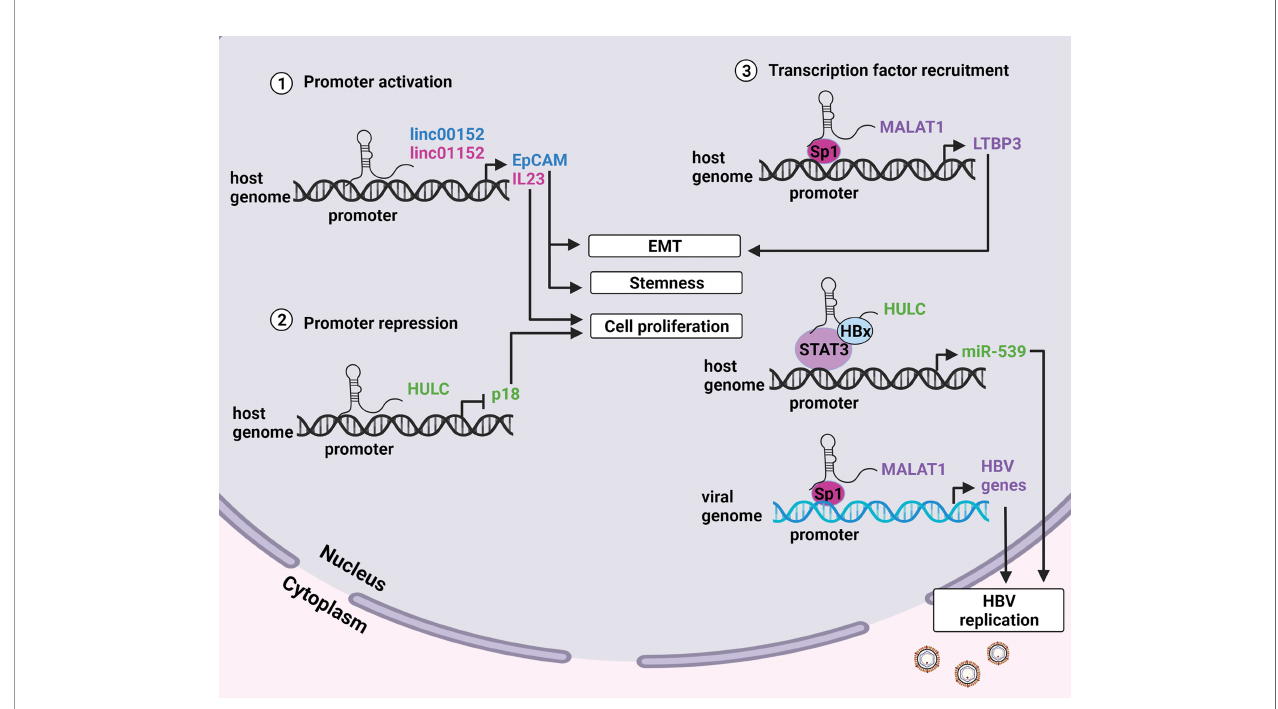
FIGURE 2 | LncRNA modulation of promoter activity. (1) LncRNAs linc00152 and linc01152 have enhancer-like properties and interact with the promoters of the EpCAM and IL23 genes respectively. EpCAM positive cells display enhanced stemness and metastatic potential, and increased levels of IL23 promote proliferation. (2) LncRNA HULC interacts with the promoter of the tumor suppressor p18 to inhibit its transcription and promote cell proliferation. (3) Certain lncRNAs can guide transcription factors to the promoters of speci fi c genes to enhance transcription. MALAT1 recruits the transcription factor Sp1 to the promoter of the LTBP3 gene on the host genome resulting in metastasis. HULC and HOTAIR recruit the transcription factors STAT3 and Sp1 to host and viral genomes respectively to enhance transcription of viral genes thus promoting HBV replication. Created with